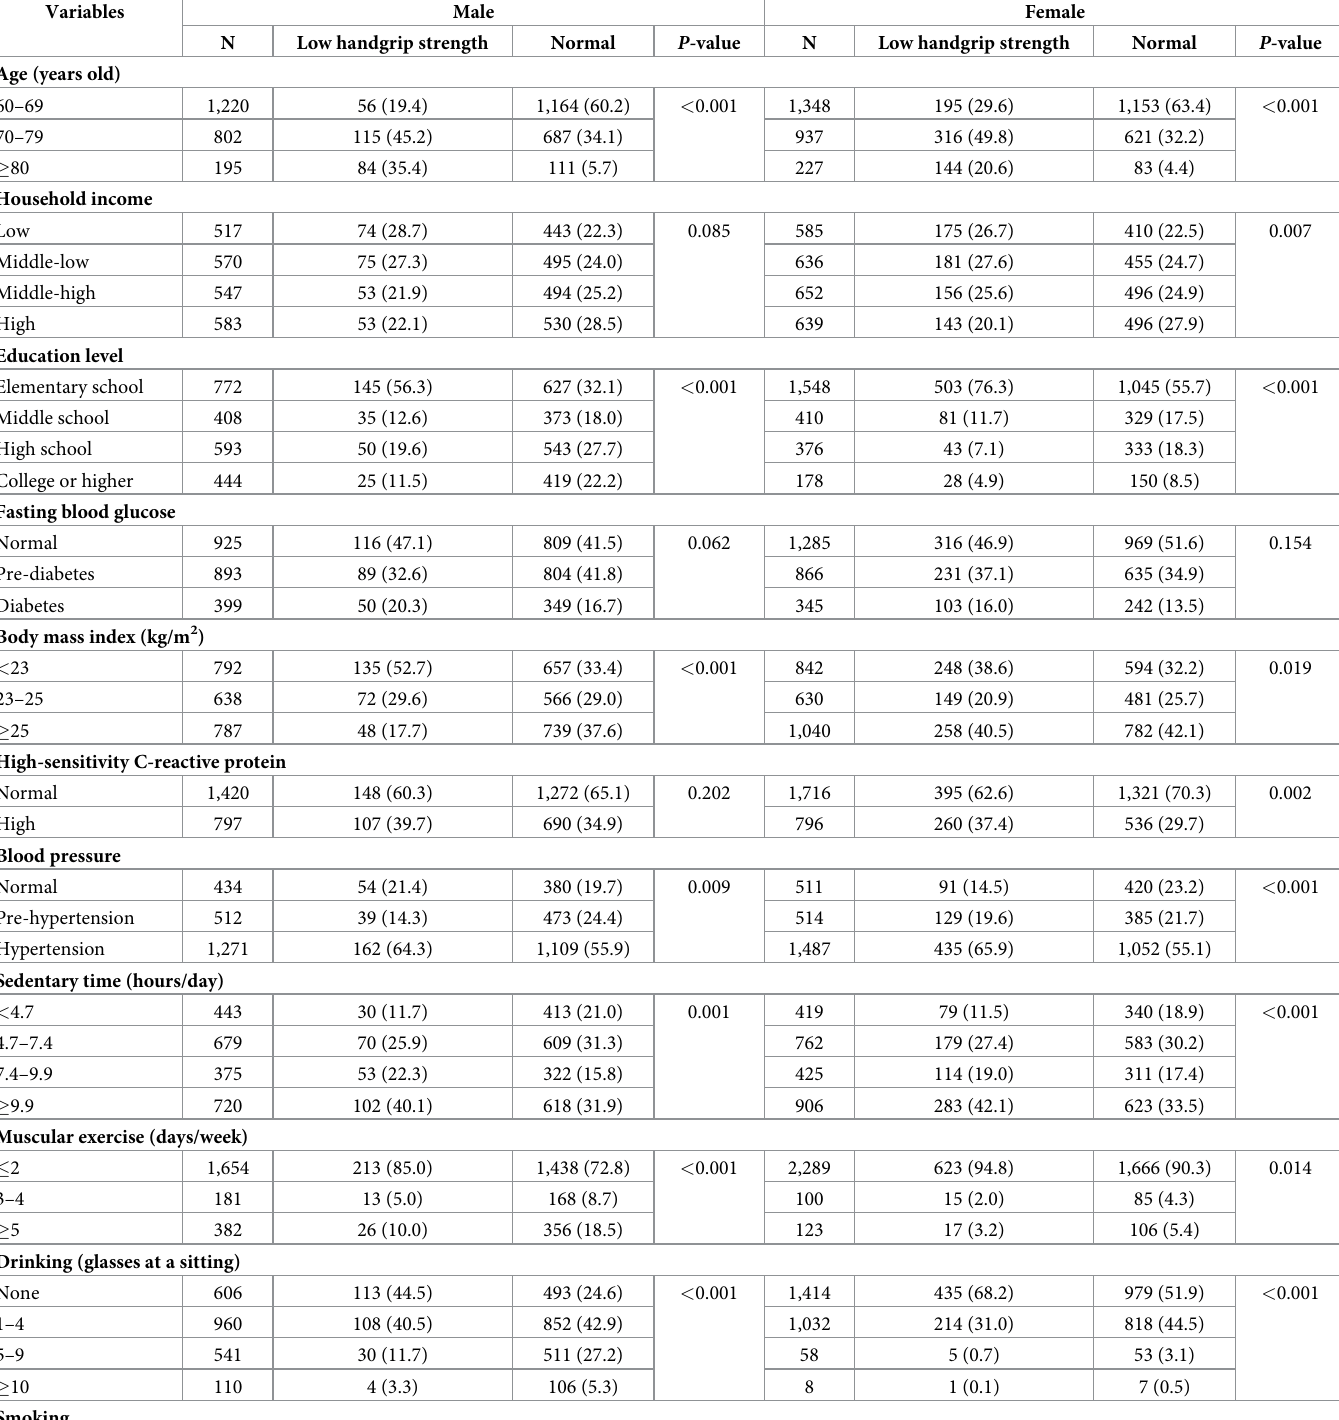
Table 1. Numbers (%) of subjects with low and normal handgrip according to general